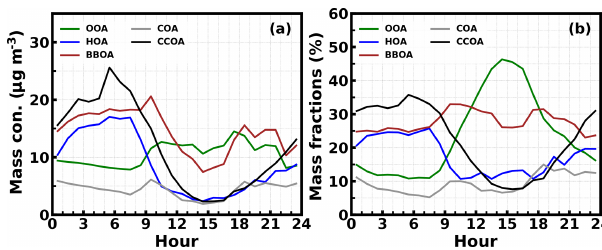
Figure 9. (a) Average diurnal profiles of mass concentrations of OOA, HOA, COA, CCOA, and BBOA. (b) Average diurnal varia- tions in mass fractions of OOA, HOA, COA, CCOA, and